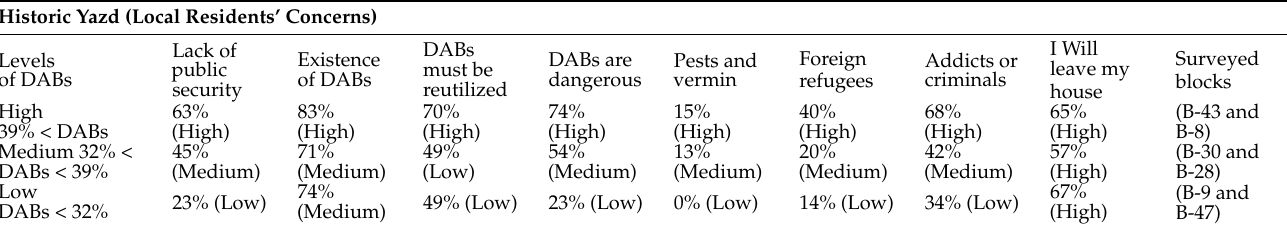
Table 4. Analysing aspects of spatial liminality in 12 urban